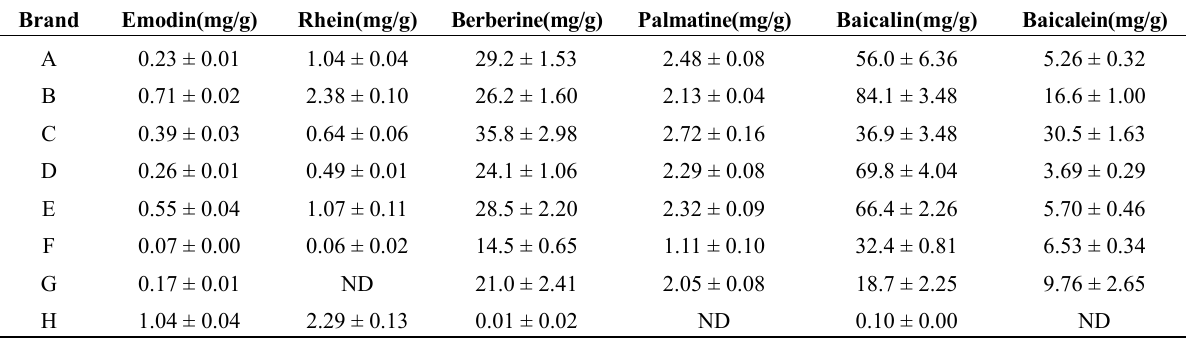
Table 2. The contents of various constituents in 7 brands of commercial pharmaceutical herbal